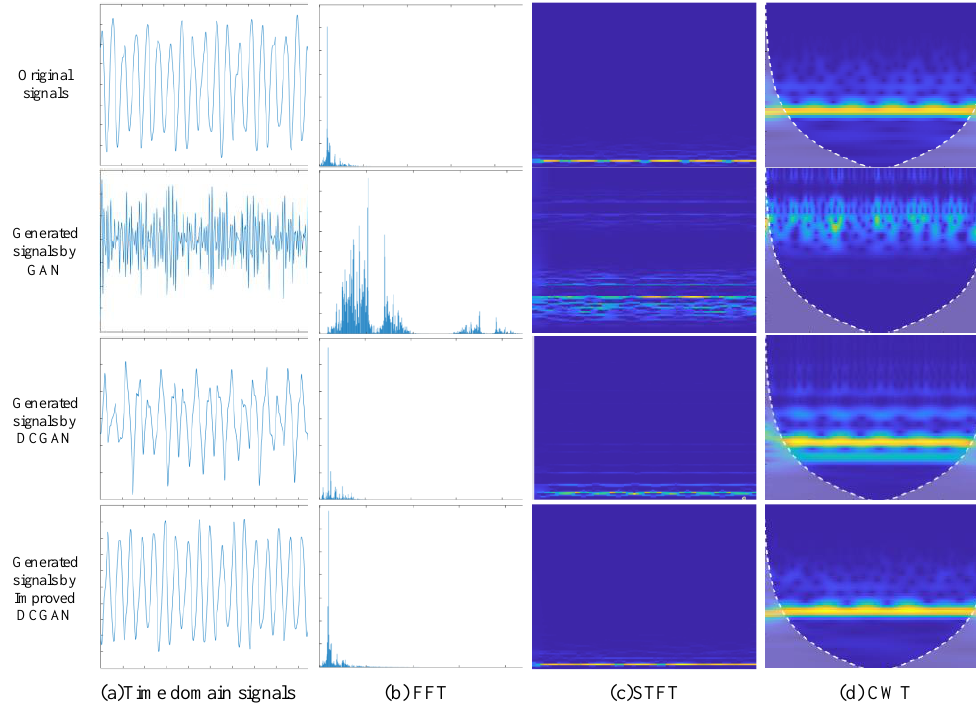
Figure 16. Signal comparison of time domain and frequency domain of the original signals and the generated signals in unbalanced state.